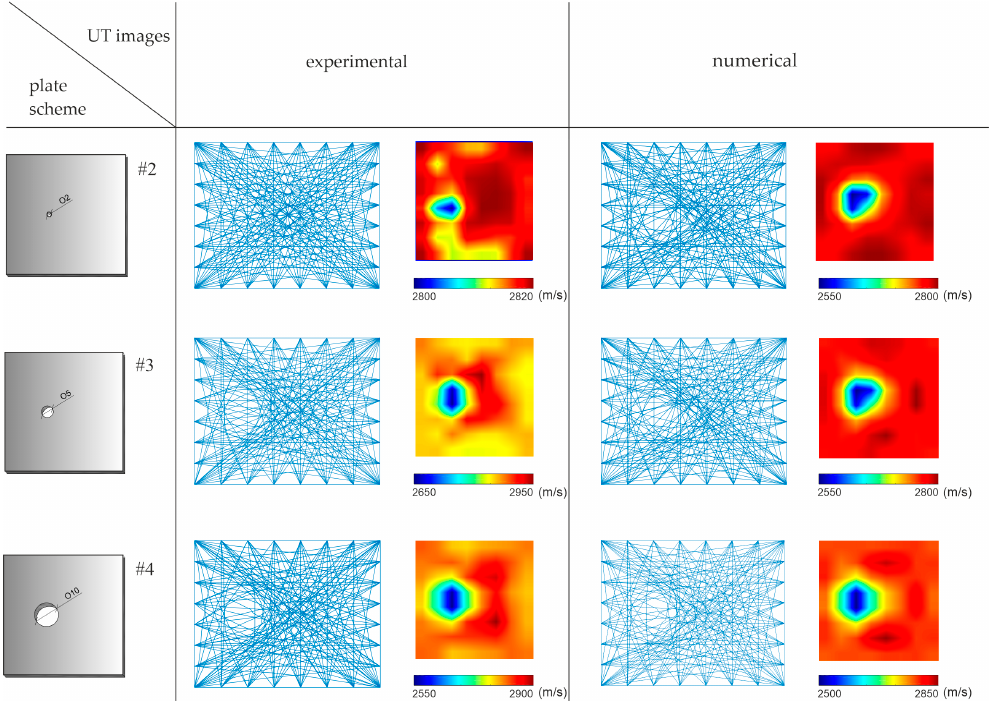
Figure 13. Ultrasonic tomography (UT) maps using direct travel time measurements with curved paths.